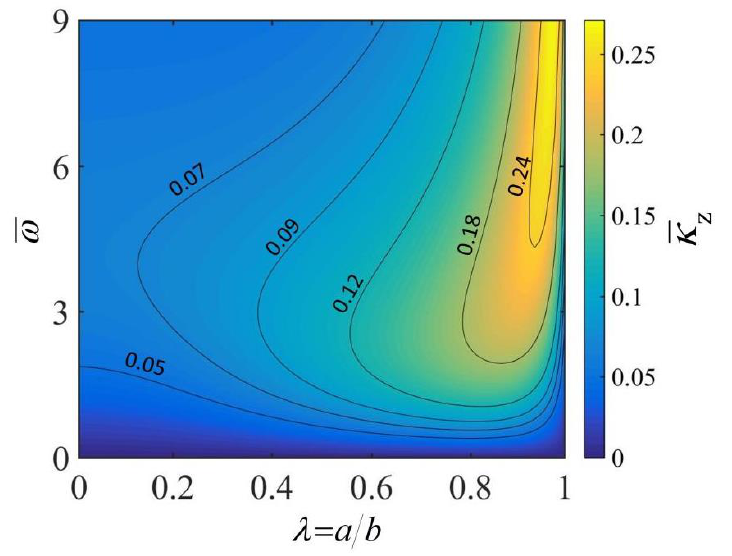
Figure 3. The effects of rolling angular velocity ω and radius ratio λ of the thick-walled cylindrical rod on the lateral curvature κ z . In the computation, we set h = 0.3, L = 10, C T = 5 × 10 − 3 , q = 30 and θ 0 = 0.2. In this case, the rolling velocity of the rod is one of the output parameters. For a given angular velocity ω , there exists a radius ratio λ corresponding to an optimal lateral curvature κ z